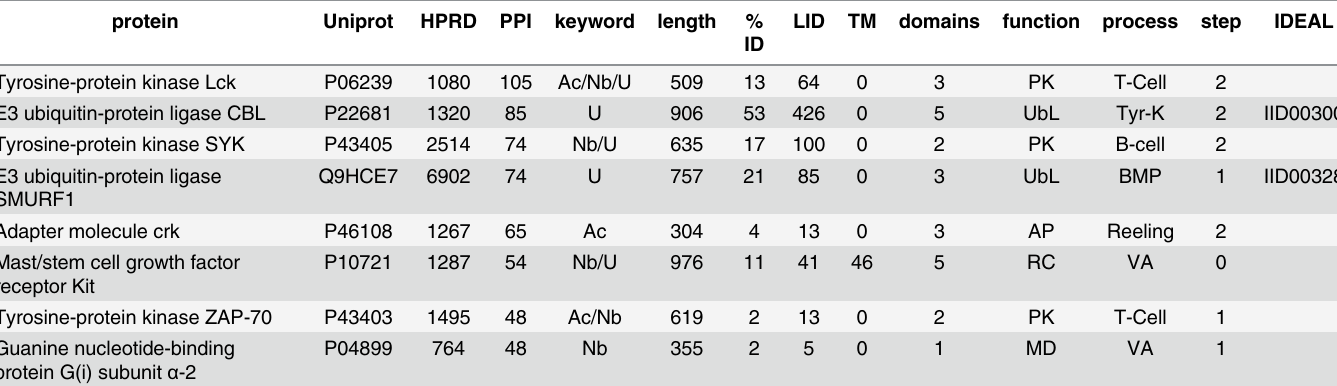
Table 2. Hub proteins localized in both the cytoplasm and cell membrane, annotated by PTM ’ or nucleotide-binding.